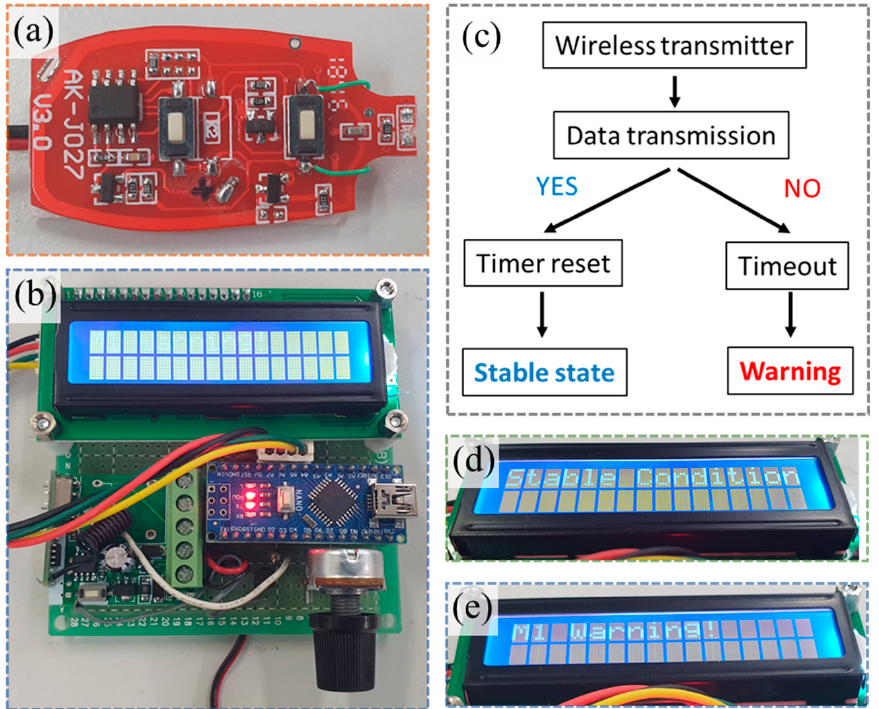
Figure 9. ( a ) Transmitter, ( b ) Receiver of the wireless communication system, ( c ) Diagram of the operating algorithm of the wireless communication system. LCD screen with ( d ) Stable and ( e ) Warning conditions.